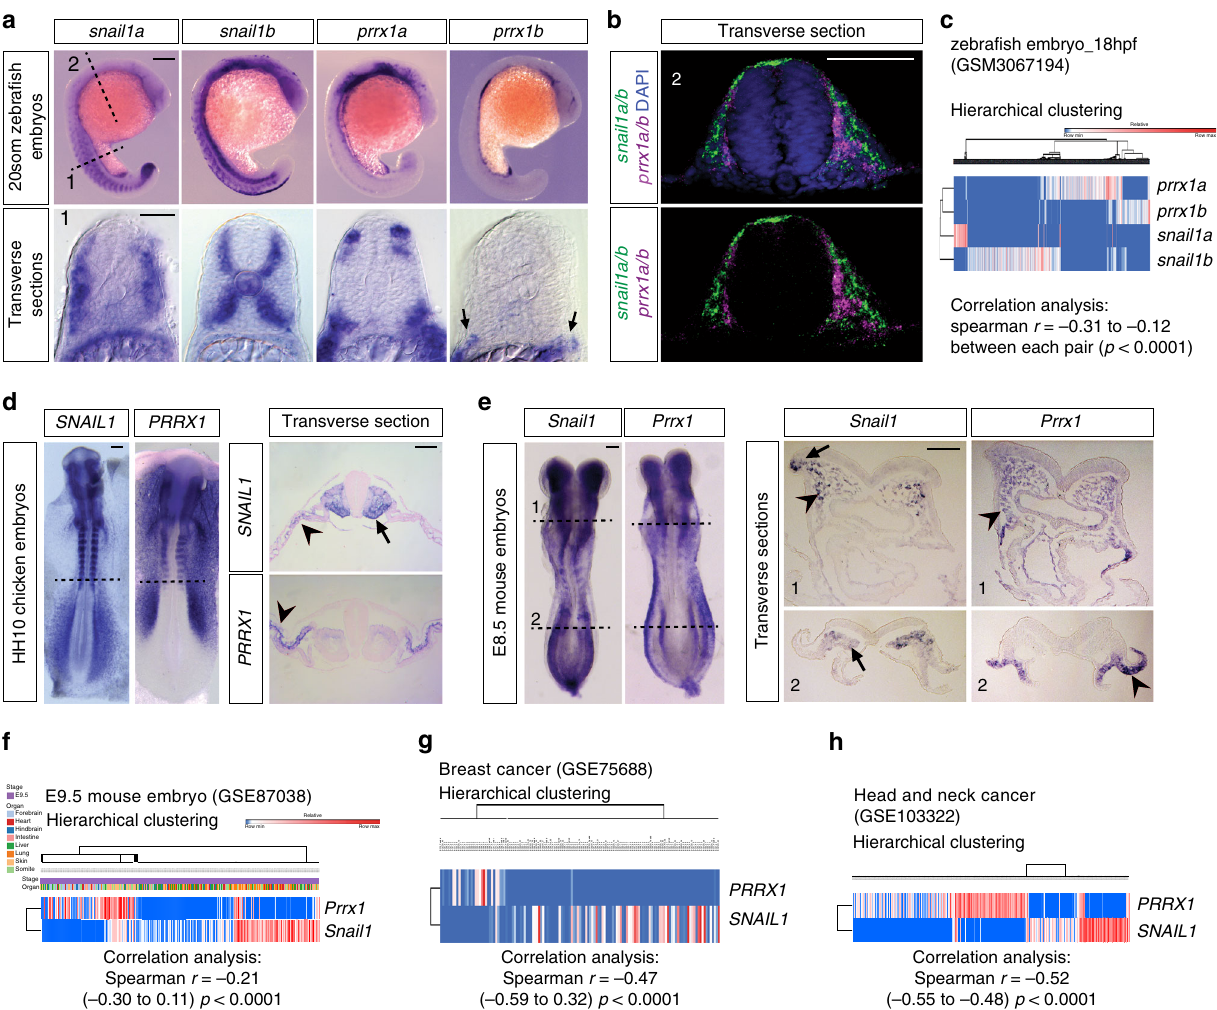
Fig. 1 Snail1 and Prrx1 complementary expression in development and disease. a Lateral view of 20-somite zebra fi sh embryos showing snail1a , snail1b , prrx1a and prrx1b expression in whole-mount (top) and transverse sections (1), showing complementary patterns in somites. b Transverse section of a zebra fi sh embryo in the cranial neural crest region showing complementary expression of snail1a/b (green) and prrx1a/b (red) taken at the level indicated by (2) in ( a ) with or without DAPI staining (nuclei). c Heatmap showing hierarchical clustering of scRNA-seq data from 18 hpf zebra fi sh embryos, from public database GEO: GSM3067194, with signi fi cant negative correlations between gene pairs (detailed in Supplementary Fig. 1a). d Dorsal view of HH10 chicken embryos showing PRRX1 and SNAIL1 expression in whole-mount and transverse sections at the level indicated by dashed lines, showing complementary patterns for SNAIL1 and PRRX1 In the somites (arrow) and in the LPM (splanchnopleura and somatopleura, respectively; arrowheads). e Expression of Snail1 and Prrx1 in dorsal views of E8.5 mouse embryos. Transverse sections of E8.5 embryos from the regions indicated by dashed lines (anterior and posterior, 1 and 2, respectively), showing complementary expression of Snail1 and Prrx1 in premigratory (1, arrow), and migratory (1, arrowheads) neural crest (PNC and MNC, respectively) and mesodermal populations including presomitic mesoderm (2, arrow) and lateral plate mesoderm (2, arrowhead). f Hierarchical clustering heatmaps of scRNA-seq data from E9,5 mouse embryos for Snail1 and Prrx1 expression (GEO: GSE87038), showing a signi fi cant negative correlation. This dataset contains cells from different embryonic tissues, shown in different colors. g , h Heatmaps of hierarchical clusterings of single-cell RNA sequencing data from public datasets of breast (GEO: GSE75688) and head and neck carcinoma (GEO: GSE103322), showing mutually exclusive expression of Snail1 and Prrx1. The color scale shown in ( f ) is also valid for ( g ) and ( h ), representing the normalized values for the number of reads. Scale bars: 250 μ m for whole mounts and 100 μ m for sections. Statistical analyses for scRNA-seq data has been done using Spearman r correlation test, scRNA- seq single-cell RNA sequencing, vs. versus, hpf hours post fertilization. Source data are provided as a Source Data fi